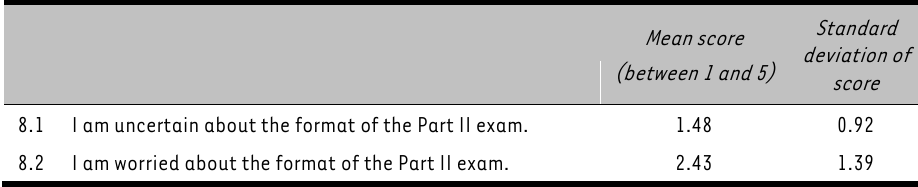
Mean score (between 1 and 5)